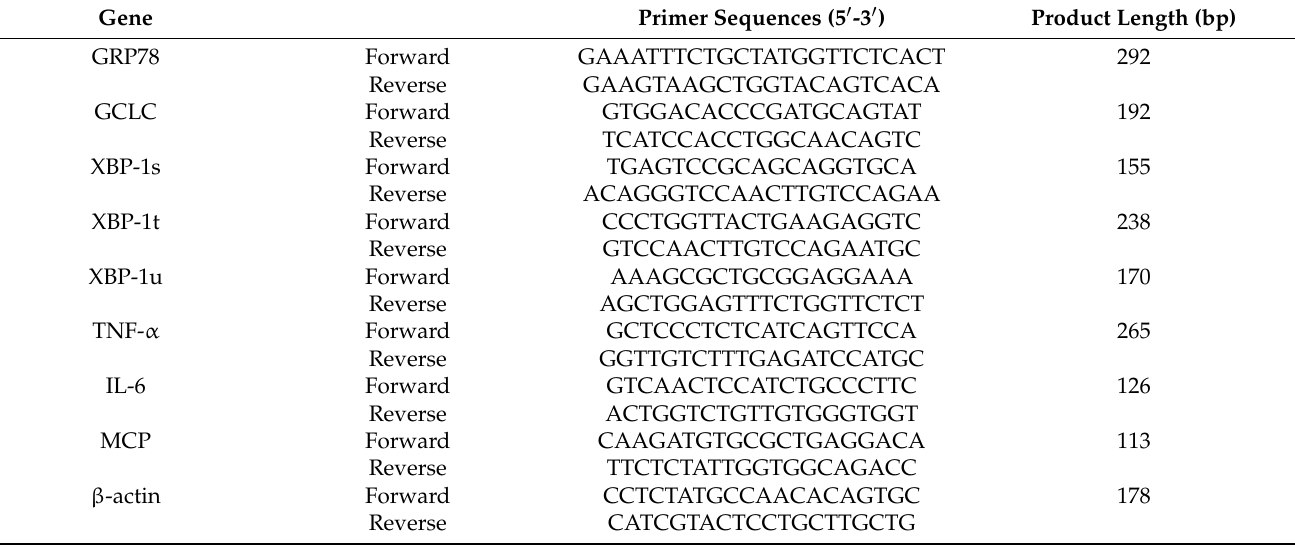
Table 9. Primer sequences for real-time PCR